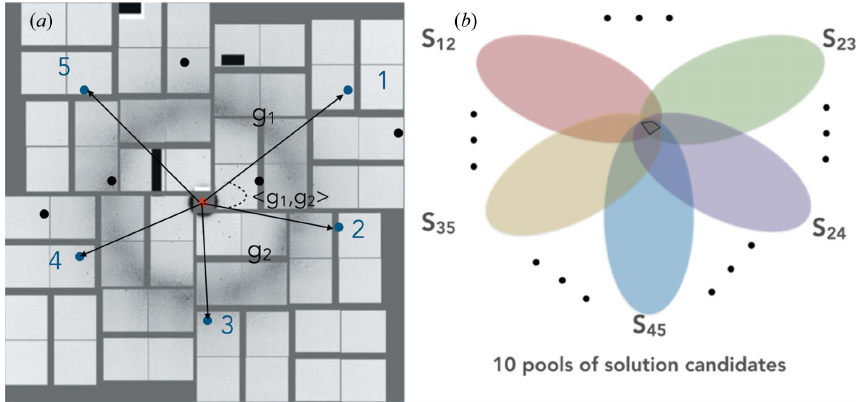
Figure 2 Illustration for SPIND auto-indexing algorithm. ( a ) A diffraction pattern recorded by Cornell-SLAC hybrid Pixel Array Detector (CSPAD) (Herrmann et al. , 2013; Hart et al. , 2012), with a few exaggerated peaks for illustrative purposes. Five peaks are selected to form ten vector pairs. The vector lengths, ratio of lengths and angles between the vectors are then calculated for the ten pairs for matching with a reference based on a priori knowledge of the unit cell (within some mismatch tolerance). ( b ) Rejection module for eliminating spurious solution candidates, based on the constraint that all peak pairs share the same crystal orientation. The solution must lie in the intersection of the solution pools, provided that the peaks are from a single crystal. unit cell with a = 9.02, b = 15.73, c = 18.82 A˚ , (cid:3) = (cid:4) = (cid:5) = 90 (cid:5) , a photon energy of 9.61 keV, 0.5 m m beam radius, 110 (cid:6) 110 m m 2 detector pixel size, and 53.2 (cid:5) maximum scattering